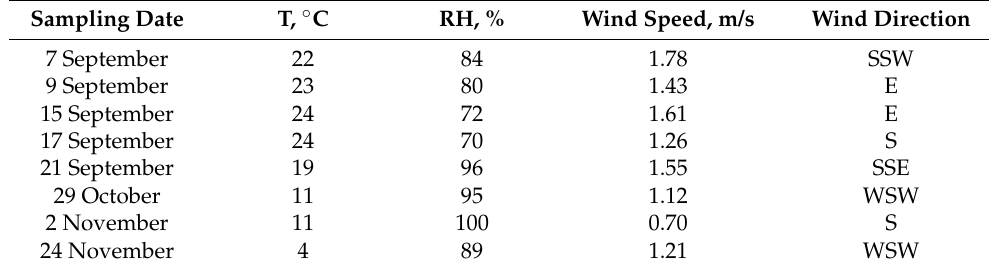
Table 2. Mean meteorological data.